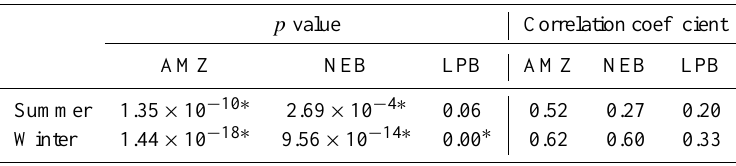
Table 4. p value and Pearson’s correlation coefficient at the level of significance of 5% between the MLR by PCs and observed data from the CRU in all regions under study.